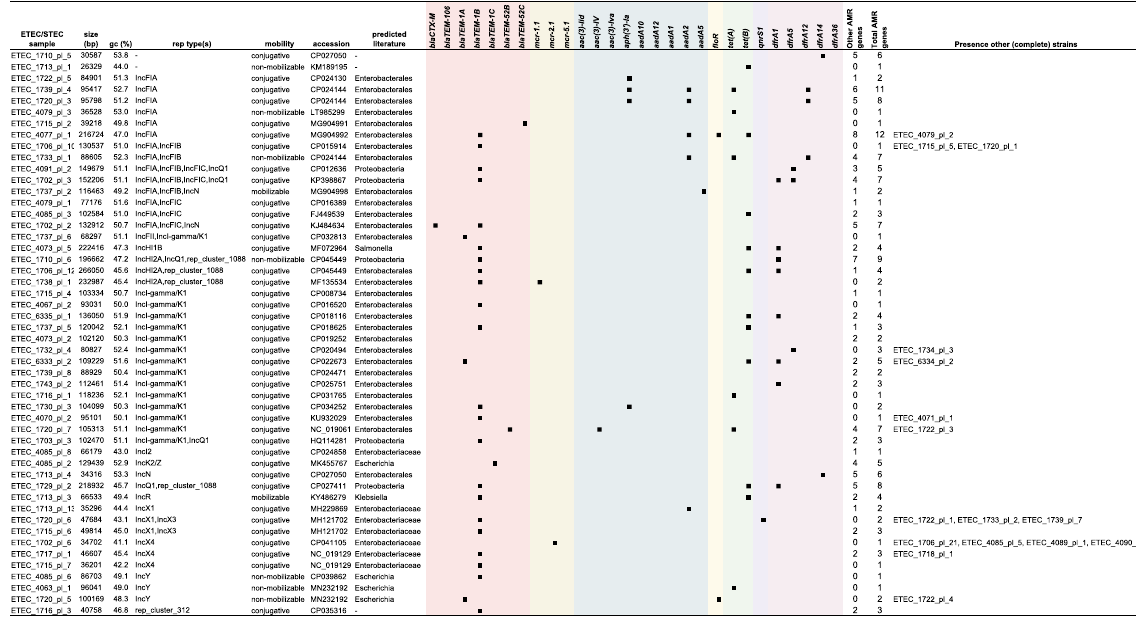
TABLE 3 In-depth characterization of AMR gene-encoding plasmids.